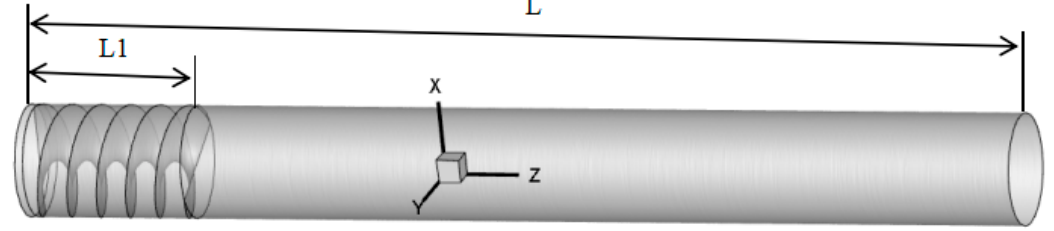
Figure 1. Calculation model.